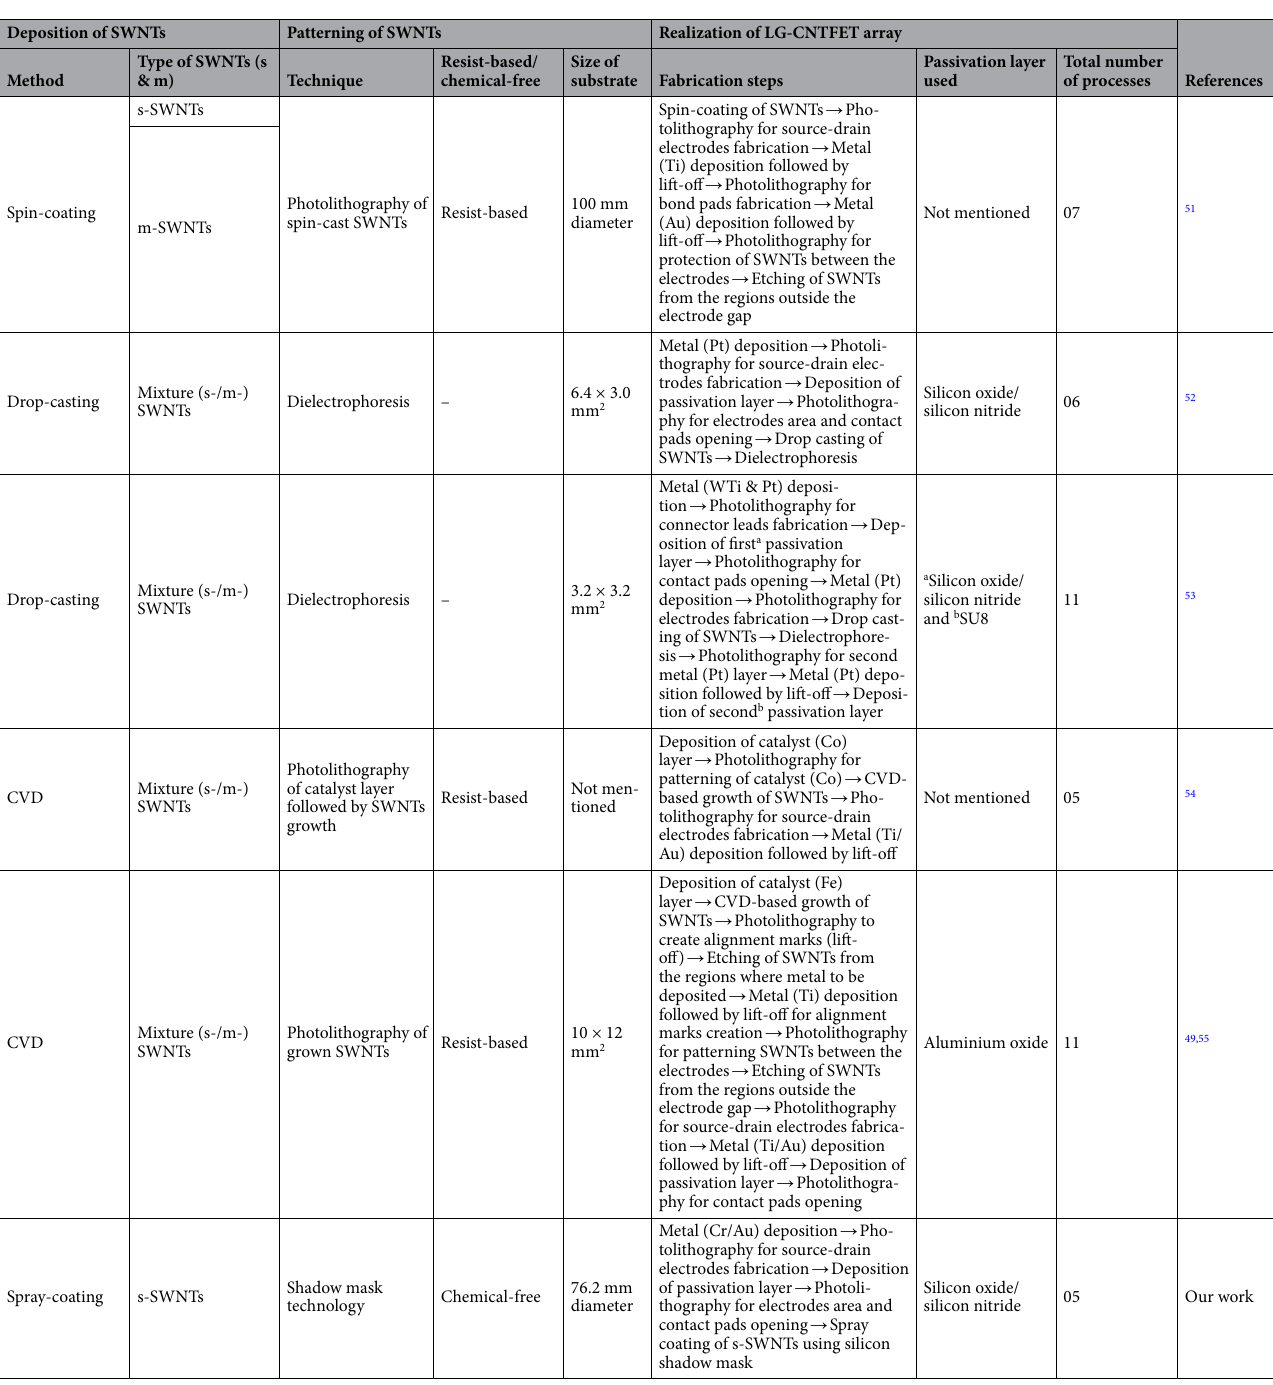
Table 1. Comparison of technologies for the fabrication of LG-CNTFET array. Ti titanium, Au gold, Pt platinum, W tungsten, Co cobalt, Fe iron, Cr